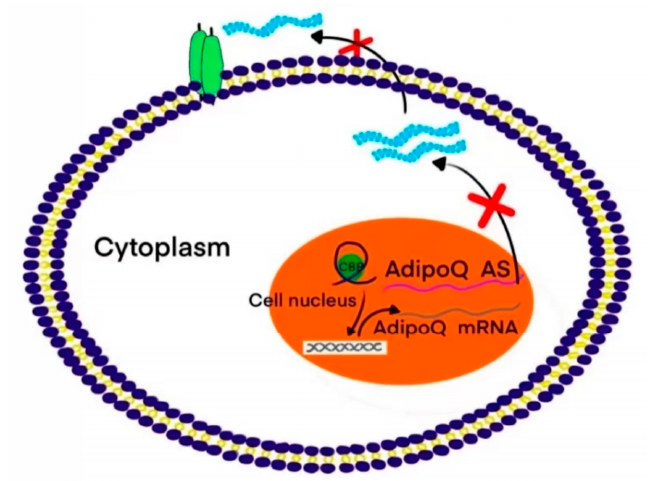
Figure 1. Interaction between lncRNA and mRNA double-stranded complexes.